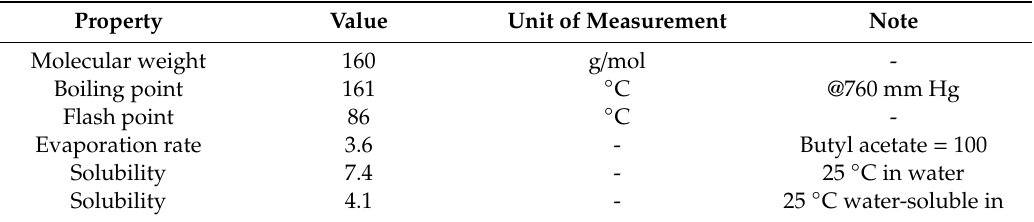
Table 3. Physical and chemical properties of Dawanol propylene glycol diacetate (PGDA). Property Value Unit of Measurement Molecular weight